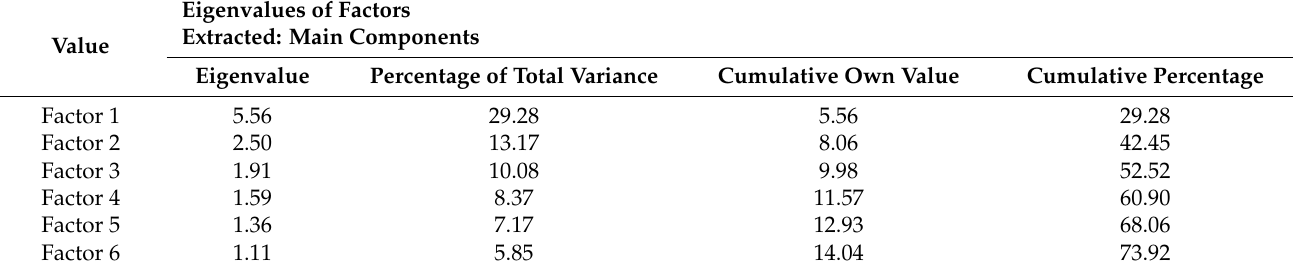
Table 4. Percentage of explained variance by individual factors after